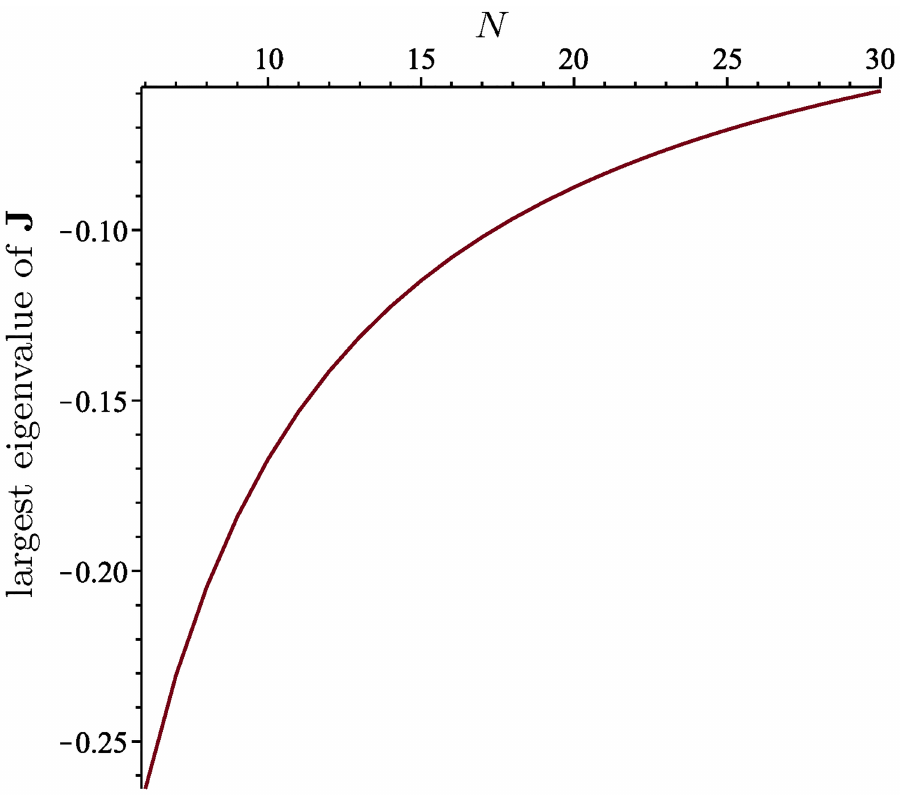
Fig 1. The largest eigenvalue of J as a function of N , for 6 (cid:20) N (cid:20) 30.